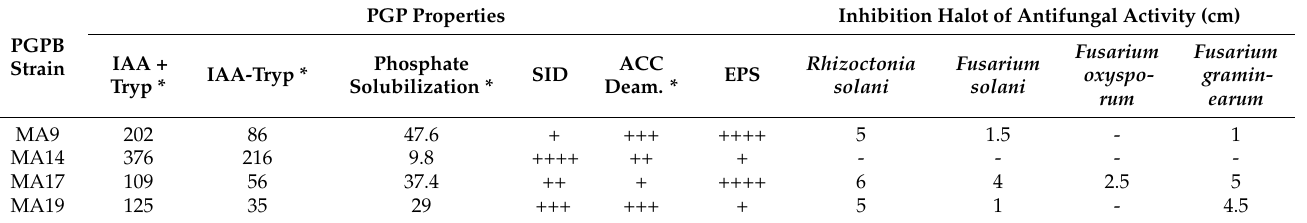
Table 1. Plant growth-promoting traits and other properties of selected isolates from coastal saline soil in